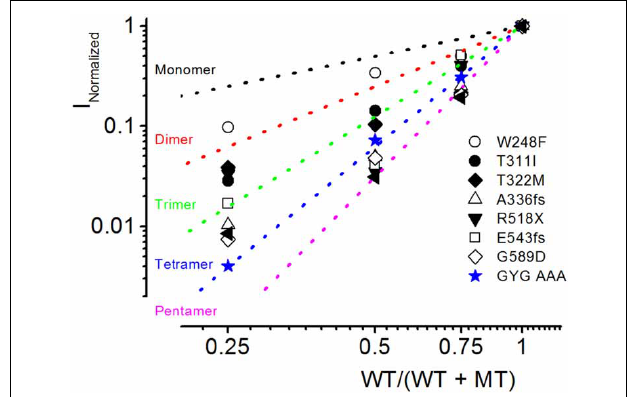
FIGURE 4 | Summary of experimental and predicted mechanisms of JLNS mutations. The four α -subunits of K + channels assemble to form a functional channel. The dotted lines denote the expected current reduction if the channels form monomers (black), dimers (red), trimers (green), tetramers (blue), and pentamers (magenta). We generated a dominant negative version of hKv7.1 in which the pore amino acids GYG (WT) were mutated to AAA (MT). The experimental data (in blue, star symbol) are in accord with the predicted relationship of tetramers, demonstrating that the WT GYG and MT AAA subunits co-assemble equally well with each other to form tetrameric functional channels. Current reduction of WT hKv7.1 by MT channels, T311I ( ), W248F ( (cid:4) ), T322M ( (cid:5) ), A336fs ( (cid:6) ) R518X ( (cid:2) ), E543fs ( (cid:7) ), G589D ( ♦ ) vs. WT/(WT + MT) ratio of DNA transfected. Reduction of WT hKv7.1 current was enhanced with decreasing WT:MT ratio. Whereas co-expression of WT hKv7.1 and the pore mutant channel AAA (dominant negative mutant) at different ratios yielded current magnitudes which confirmed the tetrameric structure of functional K + channels, the experimental data from JLNS mutants deviated from the predicted relationship of tetrameric K +